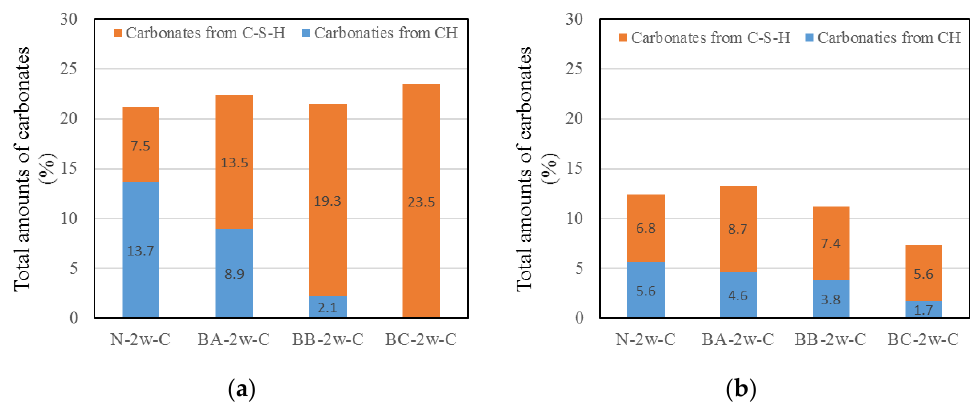
Figure 6. Carbonation of CH and calcium silicate hydrate (C–S–H) of the paste samples with different replacement ratios of blast-furnace slag (BFS). ( a ) Comparison of water curing and carbonation samples and ( b ) Comparison of air curing and carbonation samples.